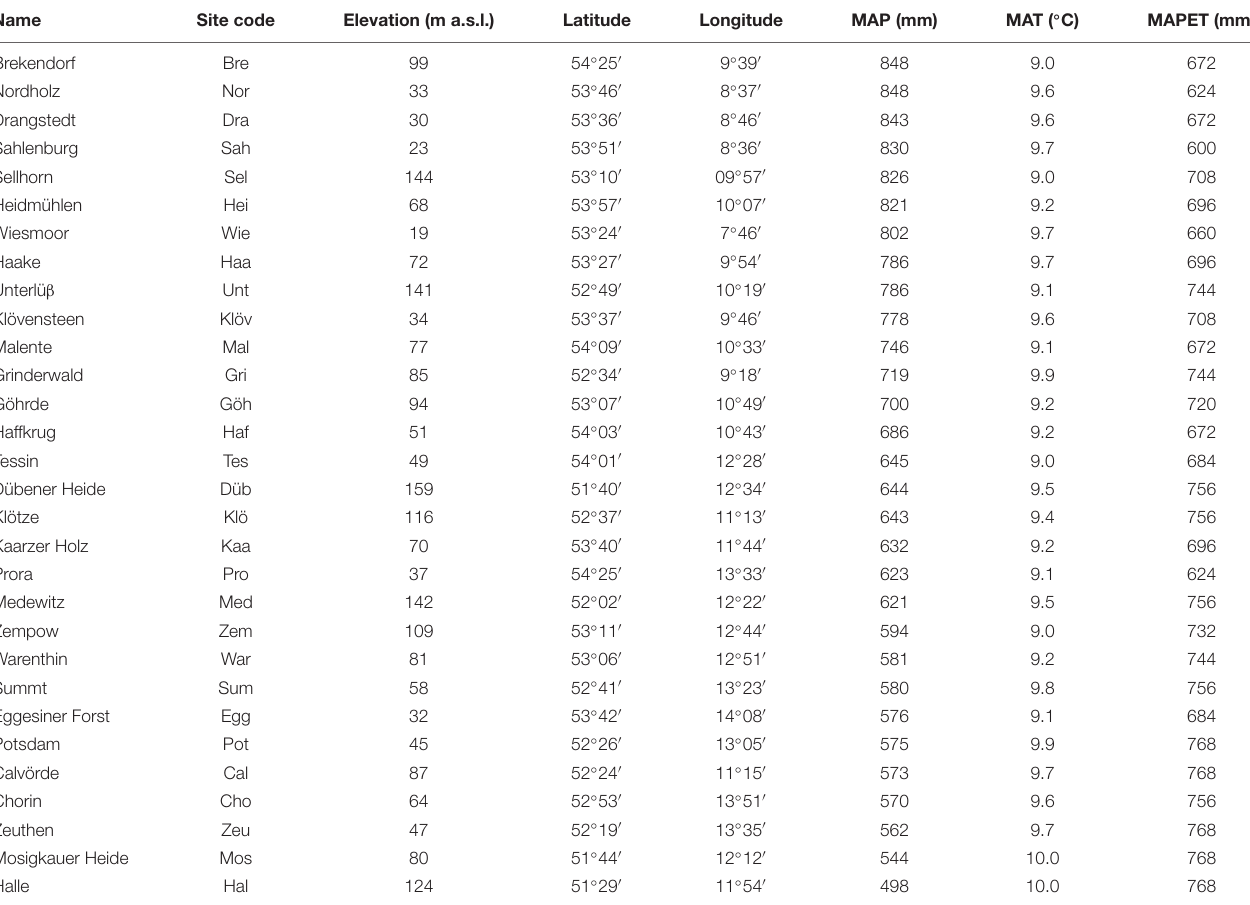
TABLE 1 | The 30 studied beech forests in northern Germany with their location, elevation, mean annual precipitation (MAP), mean annual temperature (MAT), and mean annual potential evapotranspiration (MAPET) (period 1948–2017, after